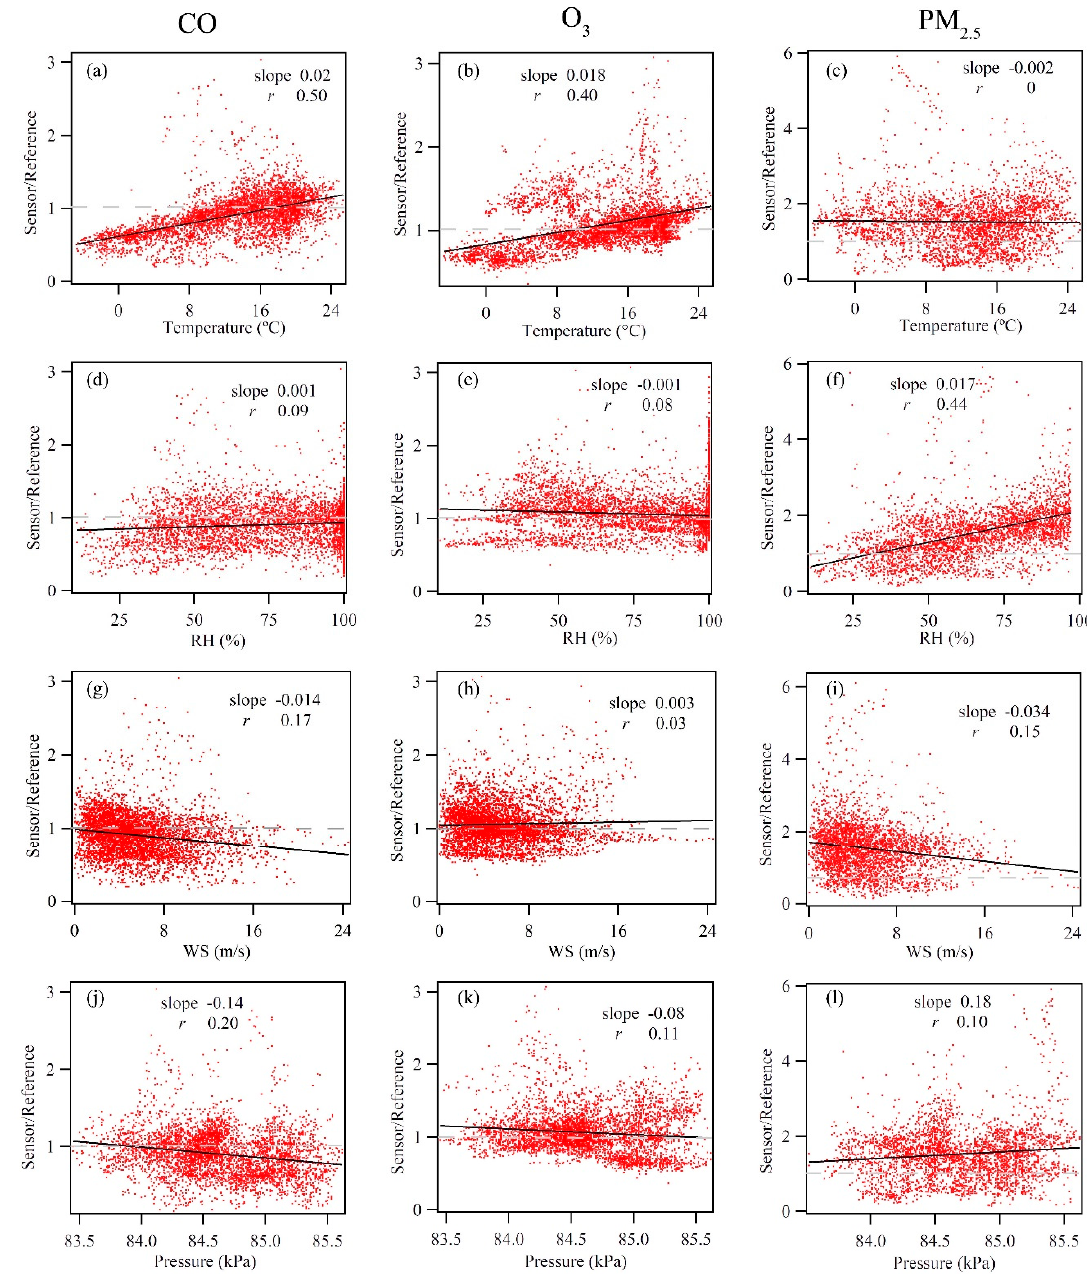
Figure 7. Scatter plots of sensor/reference ratios against meteorological factors: ( a – c ) temperature, ( d – f ) relative humidity, ( g – i ) wind speed, and ( j – l ) pressure. relative humidity, ( g – i ) wind speed, and ( j – l )